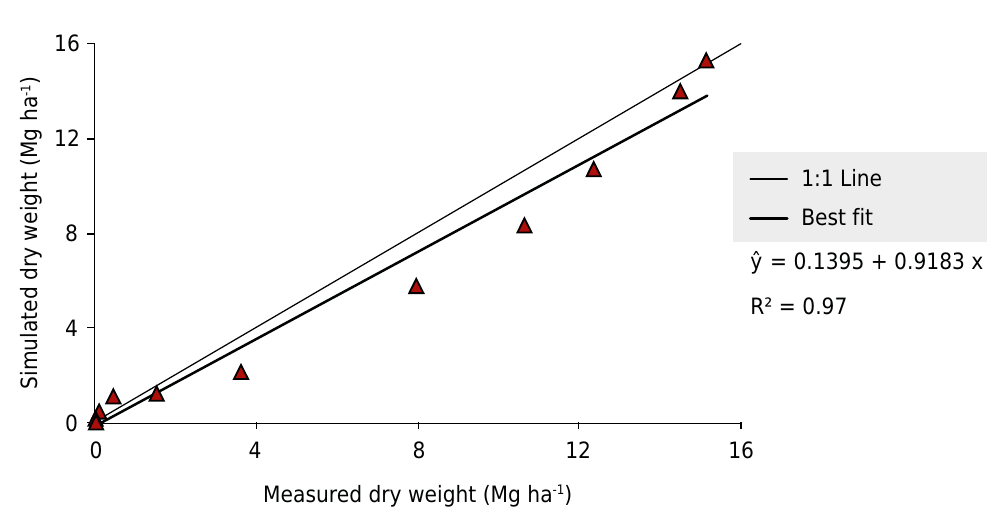
Figure 7. Overall comparison of dry weight between measurement and